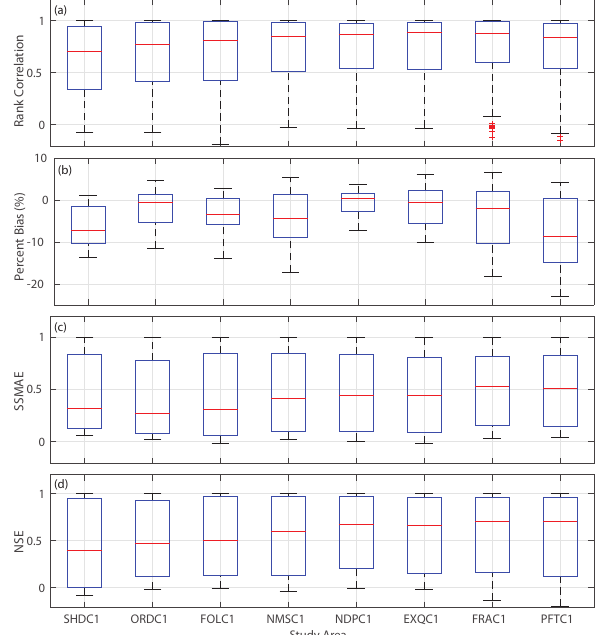
Figure 4. Boxplot of statistical metrics for median forecasts issued daily from 1 October to 31 July: ( a ) rank correlation; ( b ) percent bias (%); ( c ) mean absolute error skill score and ( d ) Nash–Sutcliffe efficiency for the study areas. The central mark on each box represents the median value; the edges of the boxes denote the 25th and 75th percentiles; the upper (lower) whisker is 1.5-times the interquartile range away from the top (bottom) of the box; the red crosses designate